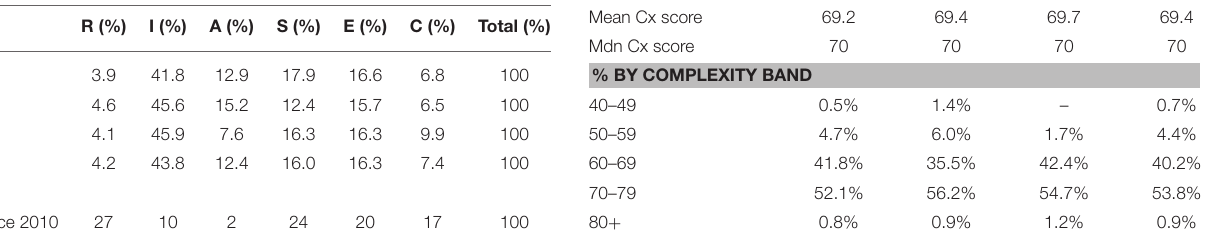
TABLE 6 | RIASEC analysis of main occupational field by expertise group in comparison with US workforce norms.